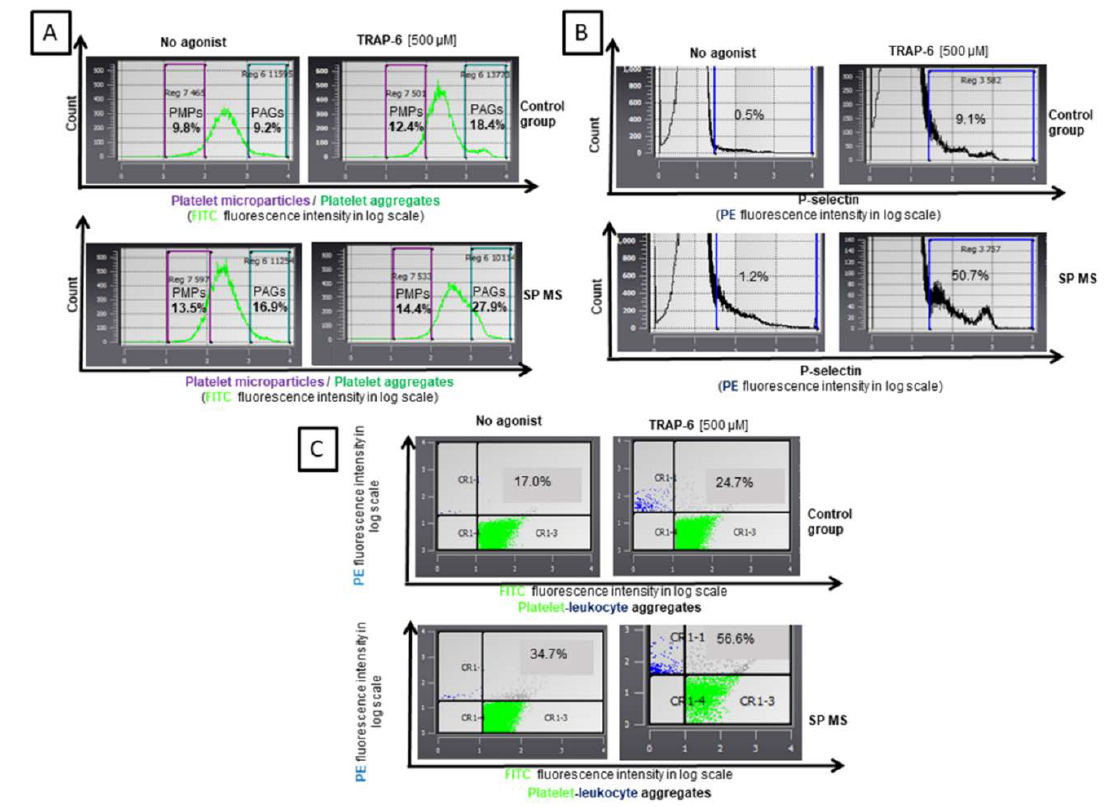
Figure 2. Representative histograms of platelet markers: %PMPs and %PAGs ( A ) and %P-selectin ( B ) and dot plots of the levels of %PLAs ( C ) in a population of resting platelets (no agonist) and in the population of TRAP-6-stimulated platelets, in whole blood samples obtained from secondary progressive (SP) multiple sclerosis (MS) patients and control group. The population of blood platelets were distinguished in whole blood based on the expression of CD61/FITC and labeled with monoclonal antibody CD62P/PE against the surface P-selectin or CD45/PE against leukocytes. All CD61/FITC-positive objects with a parameter forward scatter (FSC) below than 10 2 were characterized as PMPs, above than 10 3 as PAGs, while objects CD61/CD45-positive were recognized as PLAs. For each sample, 15,000 objects were acquired.